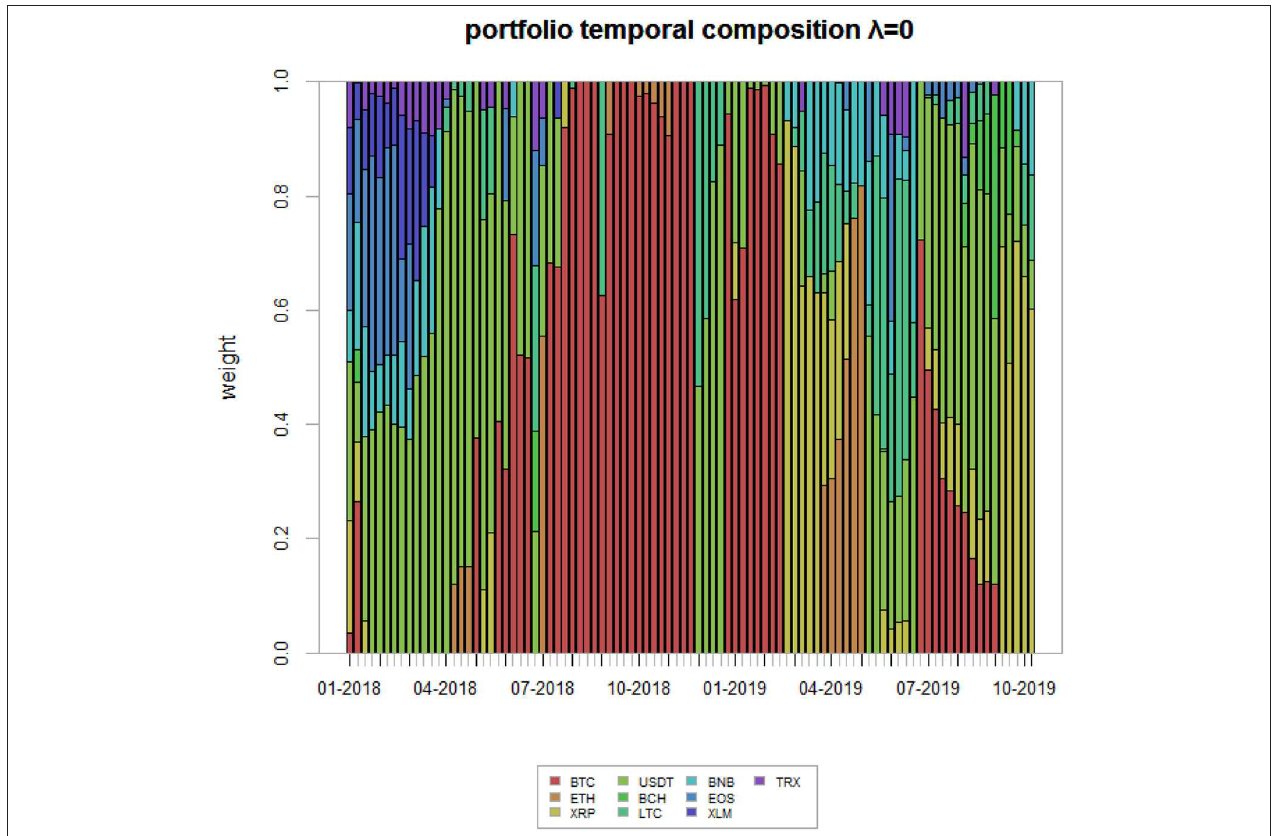
FIGURE 8 | Winning strategy portfolio weights. The figure shows the portfolio weights associated to the winning strategy—i.e., the Network Markowitz (NW)—for the analyzed time period.